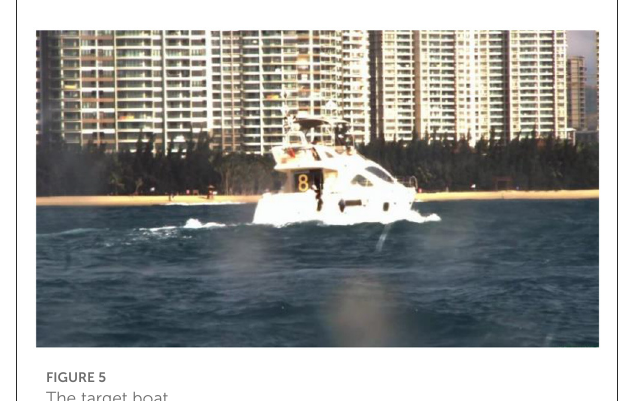
FIGURE5 The target